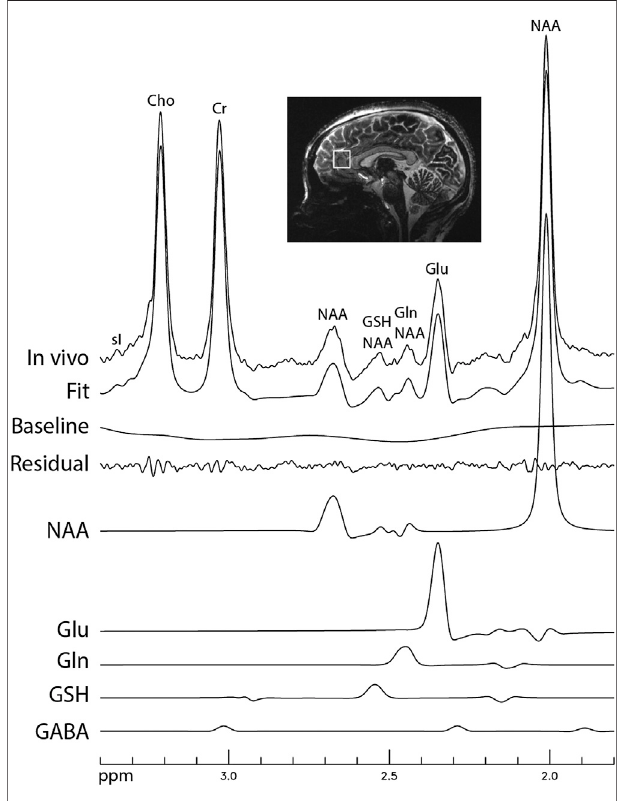
FIGURE 7 | In vivo spectrum acquired from the pregenual anterior cingulate cortex of a patient with major depressive disorder (MDD). The data acquisition parameters were the same as in Figure 6 .